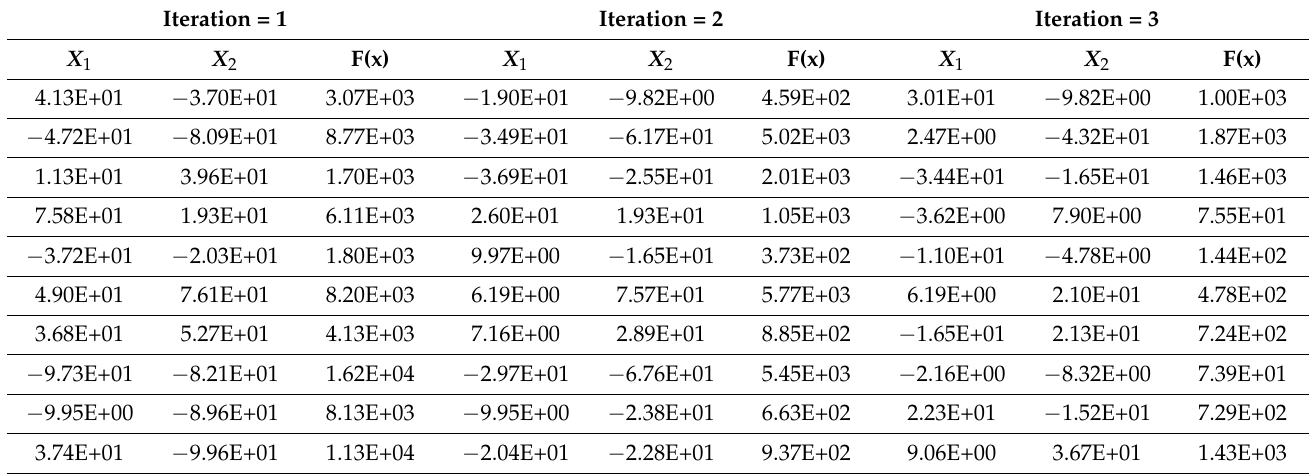
Figure 2. Search space for the test function in the BSSA . Table 1. Numerical results for the test function at different iterations.